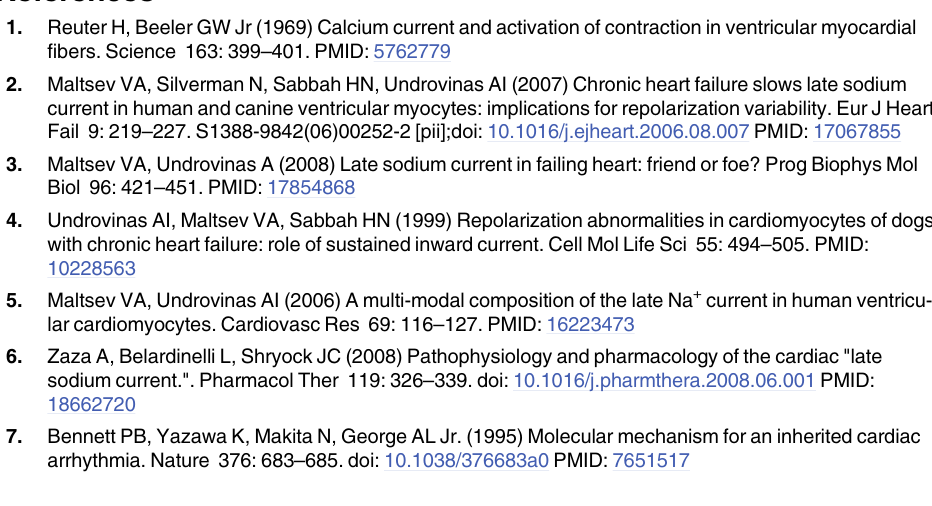
S5 Fig. Comparison of TTX-(10 μ M)-sensitive current and ranolazine-(30 μ M)-sensitive current in selected cells (upper row) with results from all cells (lower row), analysis after 50 ms and 250 ms. I in SR (black) and AF (red) was measured with protocol I and protocol Na,late II for TTX, but only with protocol I for ranolazine. Currents are expressed in pA/pF. (cid:3) P < 0.05; (cid:3)(cid:3) P < 0.01; (cid:3)(cid:3)(cid:3) P < 0.001; paired Student ’ s t-test (comparison between control and drug effect) or unpaired Student ‘ s t test with Welch ’ s correction I (comparison between SR and AF). (TIF) S6 Fig. Comparison of tetrodotoxin- and ranolazine-sensitive currents in selected cells (upper row) with results from all cells (lower row), analysis after 250 ms. Tetrodotoxin- (10 μ M)- and ranolazine-(30 μ M)-sensitive currents in human atrial SR and AF cardiomyo- cytes and tetrodotoxin-(10 μ M)-sensitive currents in WT and Δ KPQ mouse ventricular and atrial myocytes measured with both protocols (protocol Ⅰ and Ⅱ ) and analysed at -30 mV. (cid:3) P < 0.05; (cid:3)(cid:3) P < 0.01; paired Student ’ s t-test (comparison between control and drug effect) or unpaired Student ‘ s t test with Welch ’ s correction I (comparison between SR and AF). Numbers below the columns (x/y) indicate number of cells per number of patients or